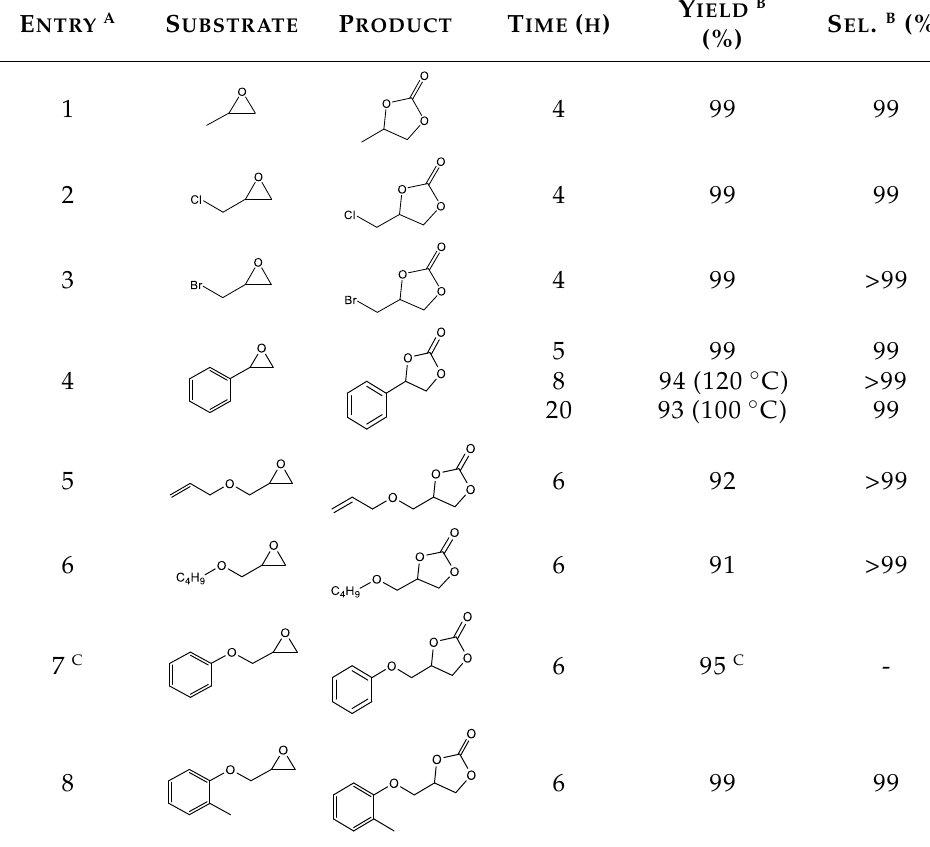
Table 2. Cycloaddition of CO 2 to various epoxides catalyzed by [HCP-CH 2 -Im][Cl]-1.